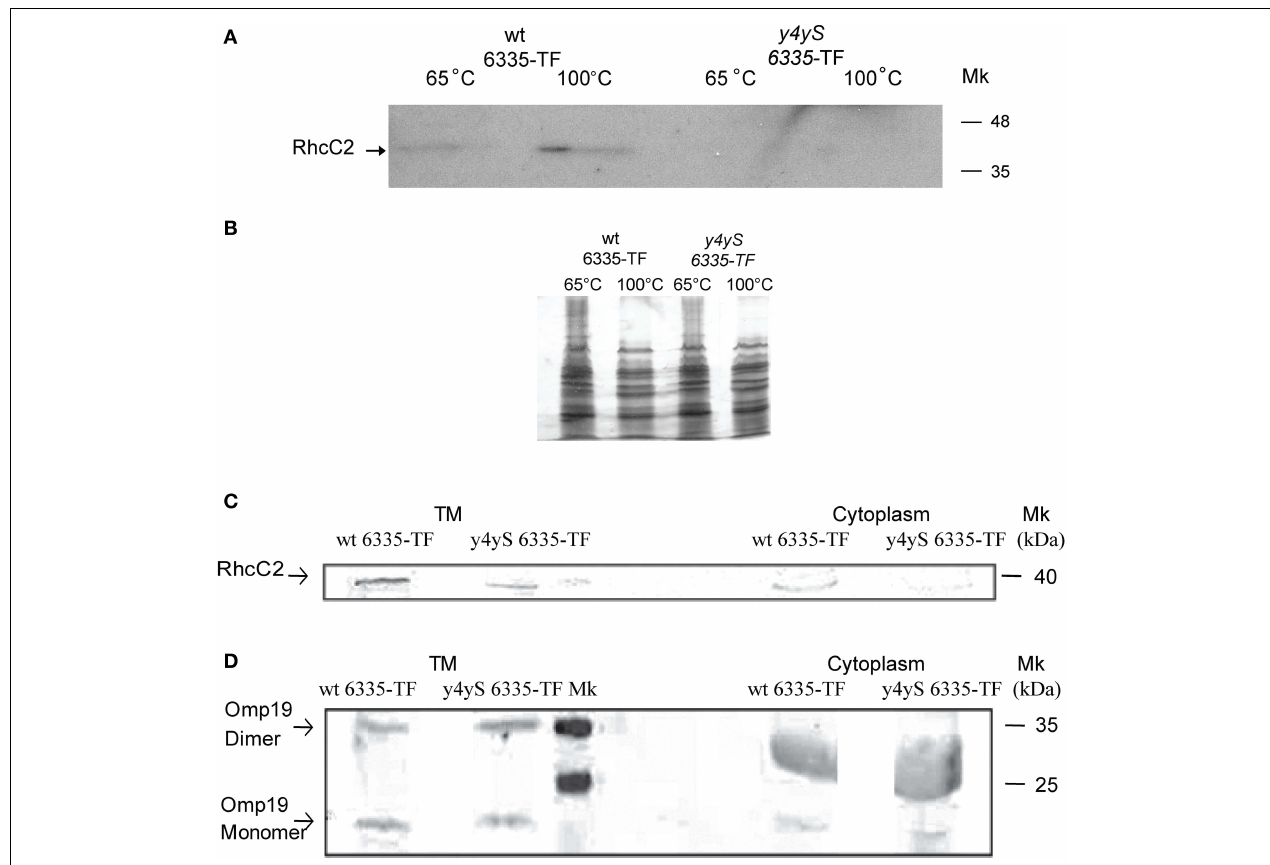
FIGURE 7 | Detection of the 3x FLAG RhcC2 fused protein. (A) OMs of wt 6335 -TF and y4yS mutant strain with sequence encoding the 3xFLAG RhcC2 fused protein integrated into the bacterial chromosome ( y4yS 6335 -TF) heated at 65 ◦ C or 100 ◦ C were separated by 15% SDS-PAGE and then immuno-bloted and probed with an anti-FLAG antibody, (B) Silver staining of samples described in A separated by 7.5% SDS-PAGE. Total membranes (TM) and cytoplasmic fractions of wt 6335 -TF and y4yS 6335 -TF strains heated at 100 ◦ C, separated by 12.5%